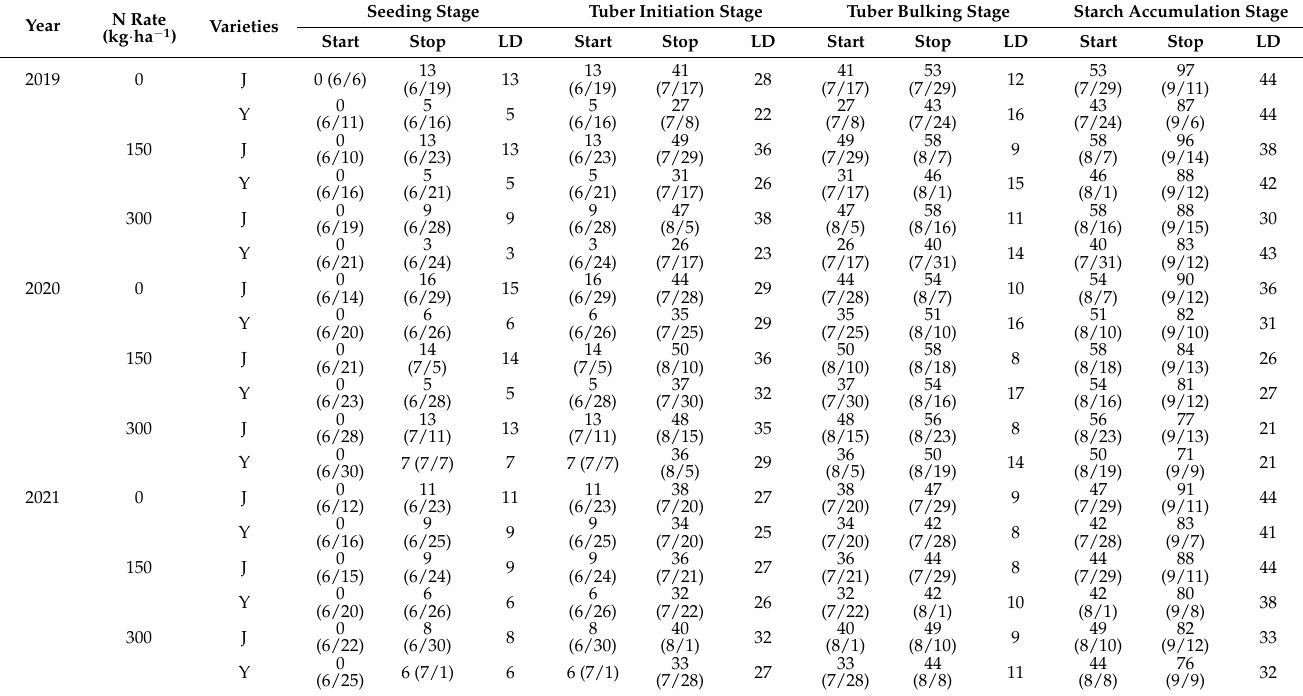
Table 7. Start and end time and duration length of growth stage of two potato varieties at different nitrogen application